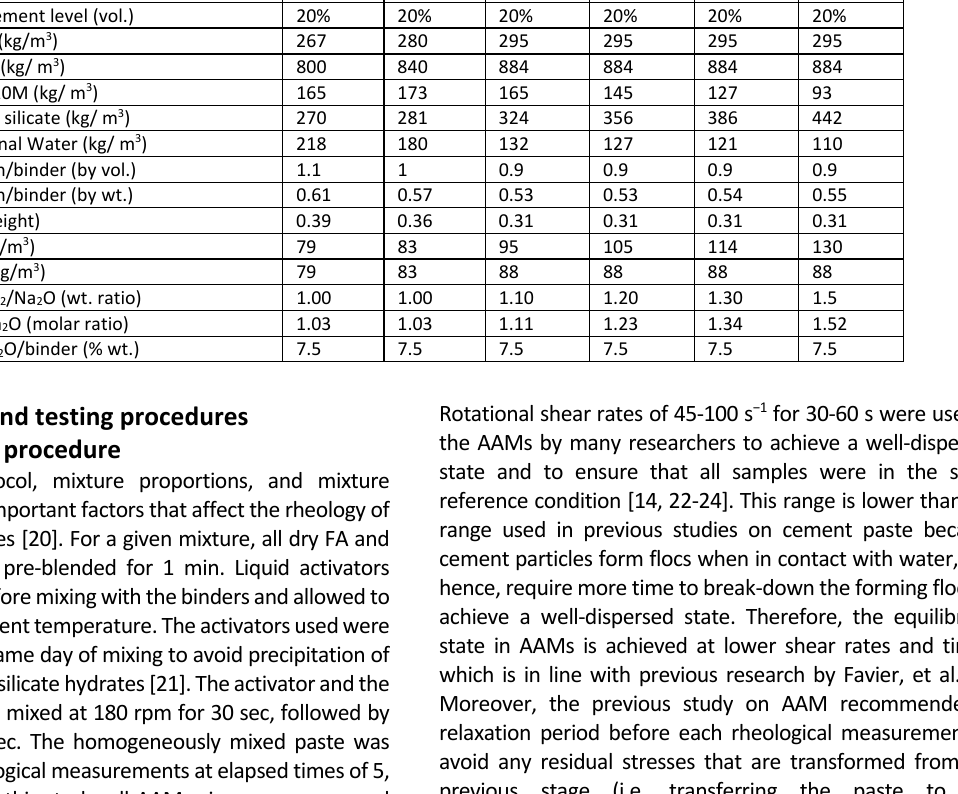
Table 3. Mixture proportions for Series II and Series III.